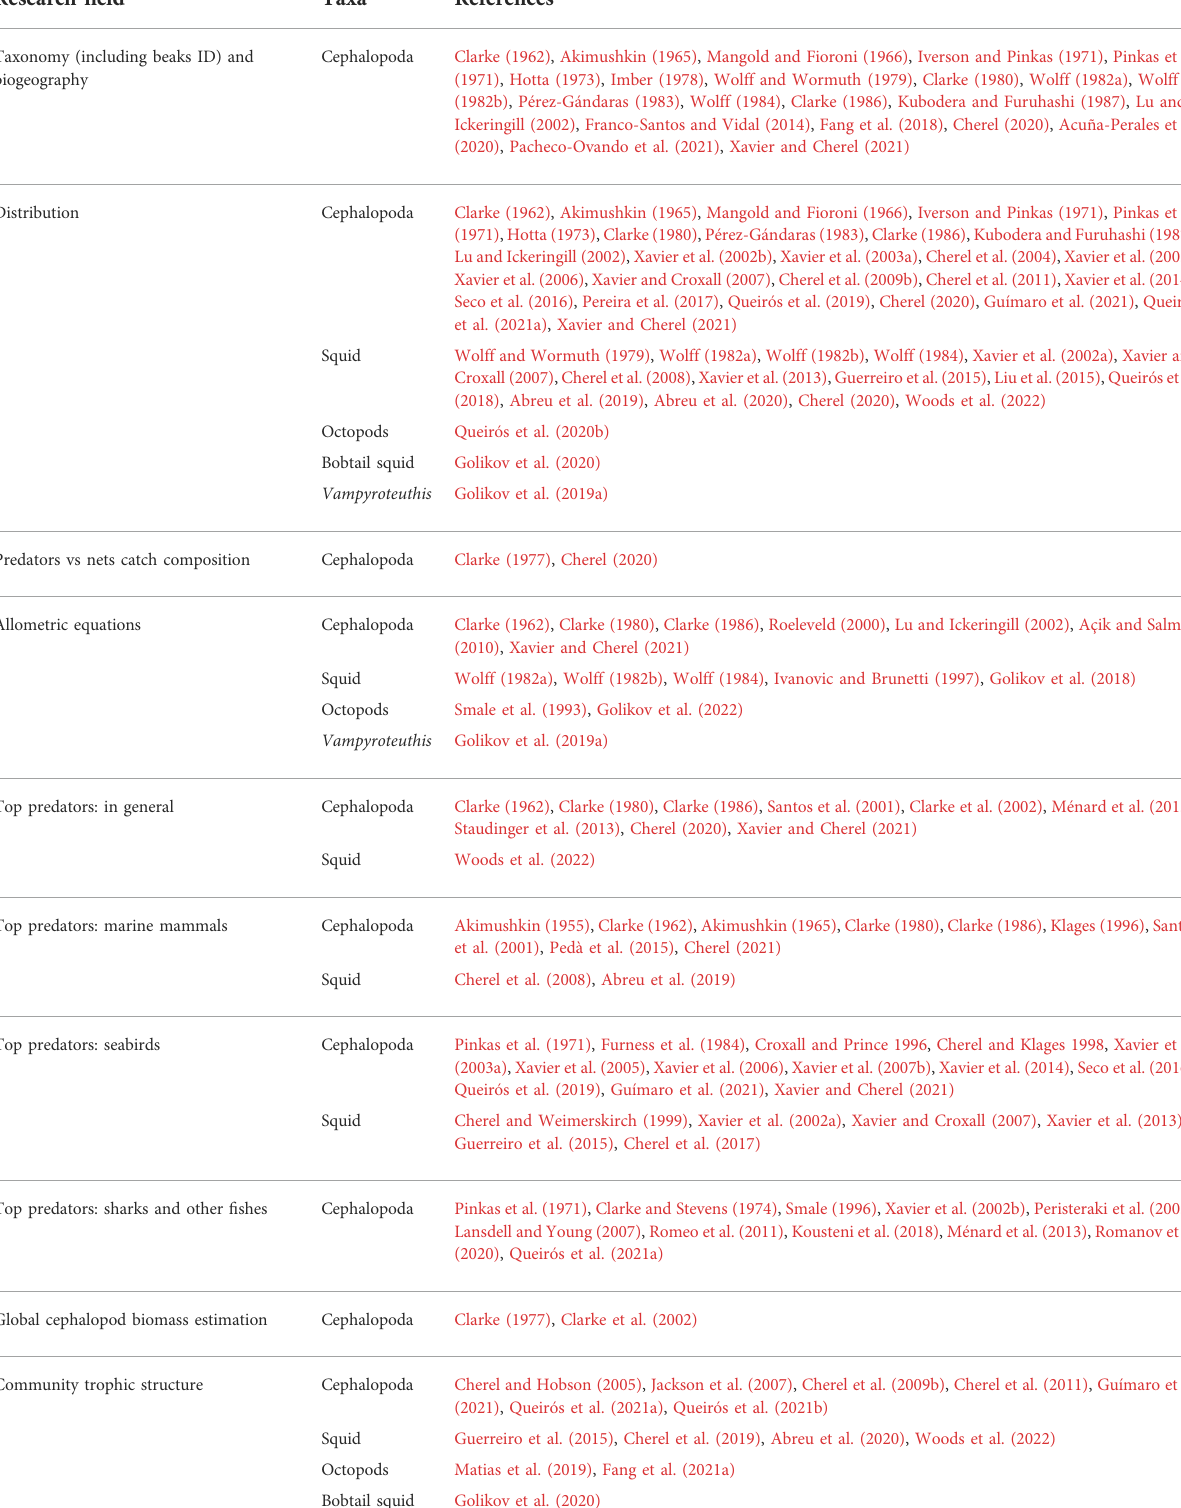
TABLE 1 A non-exhaustive overview of the use of cephalopod beaks in ecological studies and related